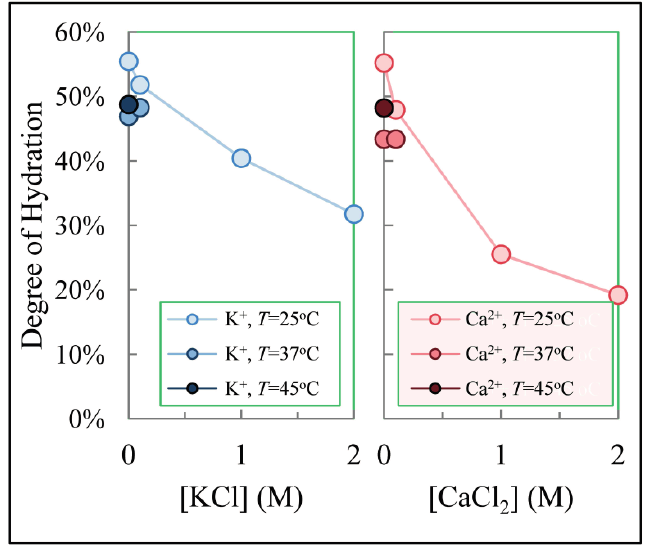
Figure 4. Degree of hydration for hydrogels as a function of the bathing solution salt concentration and